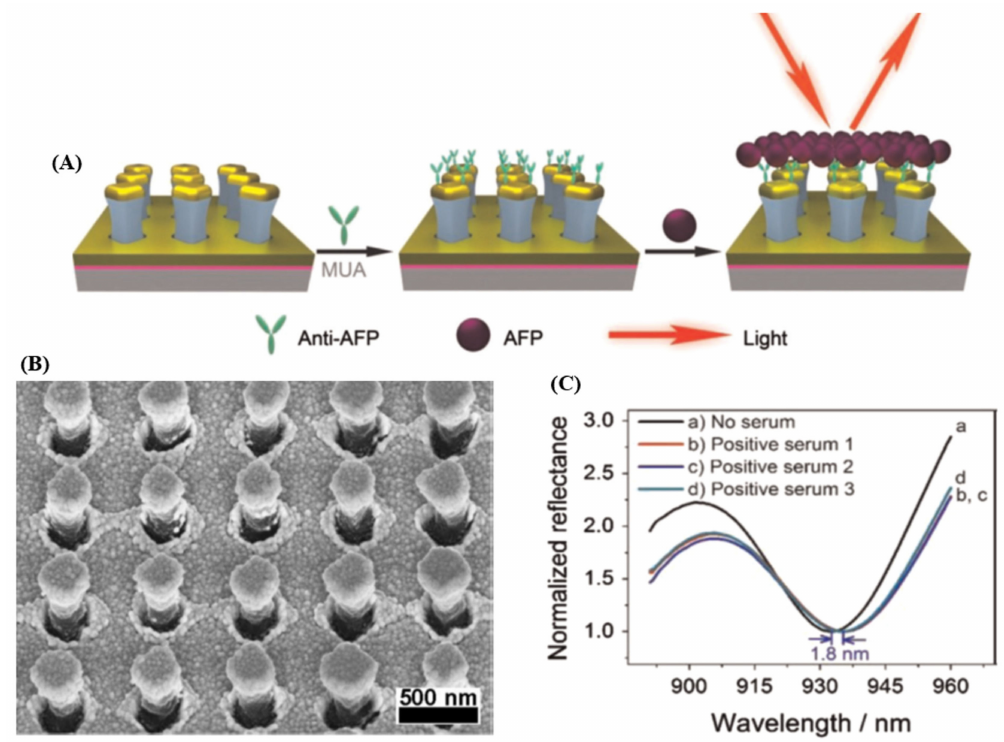
Figure 1. ( A ) Schematic illustration presenting the covalent functionalization of the fabricated plasmonic biosensor with anti-alpha-fetoprotein (AFP) for label-free and one-step localized surface plasmon resonance (LSPR) detection of AFP; ( B ) Representative SEM image of the fabricated plasmonic substrate; ( C ) Normalized reflectance spectra of the plasmonic biosensor before (a) and after (b–d) exposure to human serum sample three times. (Reproduced with permission from Reference [17] published by